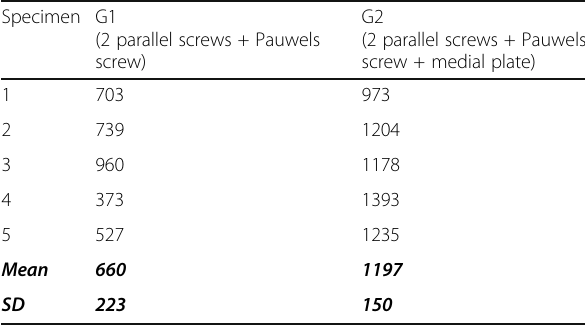
Table 1 Load values in newtons (N) for 5.0 mm of displacement Specimen G1 (2 parallel screws + Pauwels